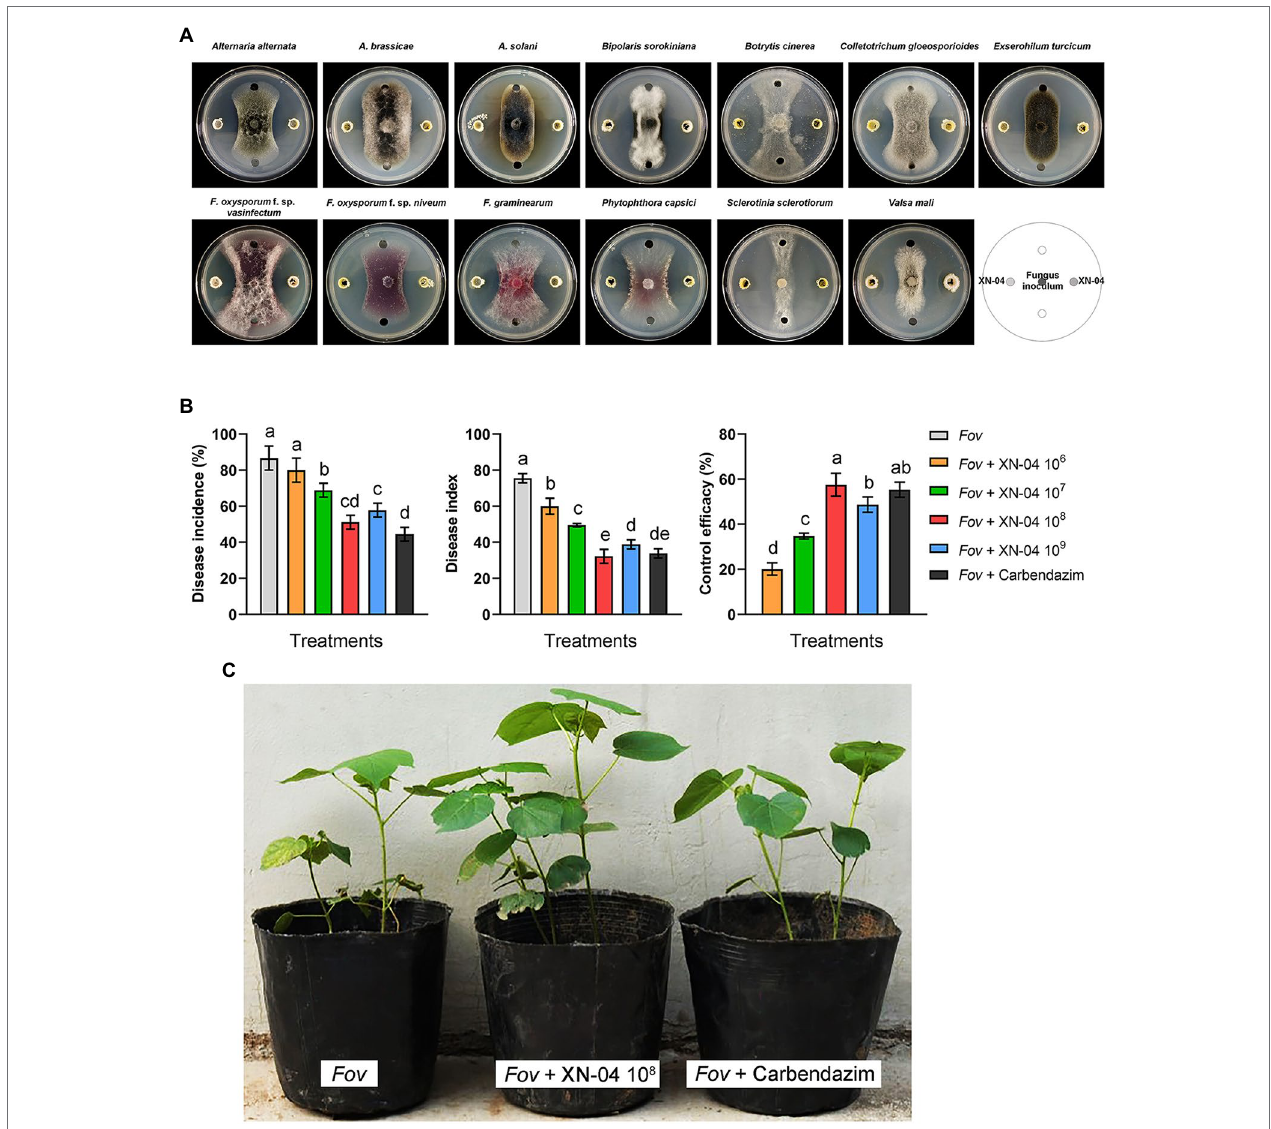
FIGURE 1 | The antifungal activity of XN-04. (A) Antagonistic activity of XN-04 against 13 important phytopathogenic fungi; (B) biocontrol efficacy of XN-04 against Fov under greenhouse conditions; and (C) the symptoms of Fusarium wilt disease development on cotton in each treatment in greenhouse experiment. Data are mean ± SD ( n = 5). Different lowercase letters indicate a significant difference at p < 0.05 level by Duncan’s new multiple range